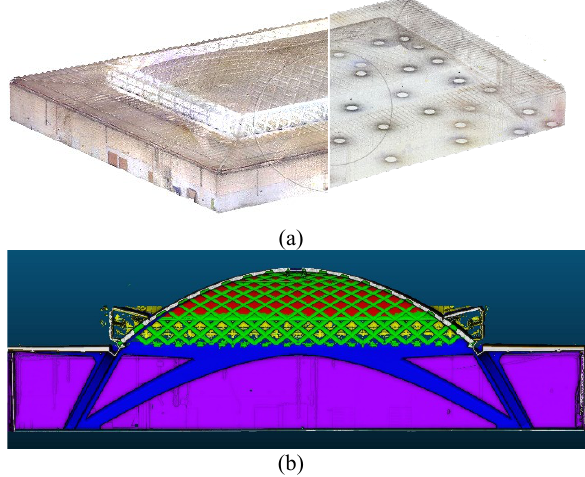
Figure 5. The static LiDAR point cloud: (a) the complete point cloud with indication of scan positions; (b) the optimized and segmented point cloud referring to the structural